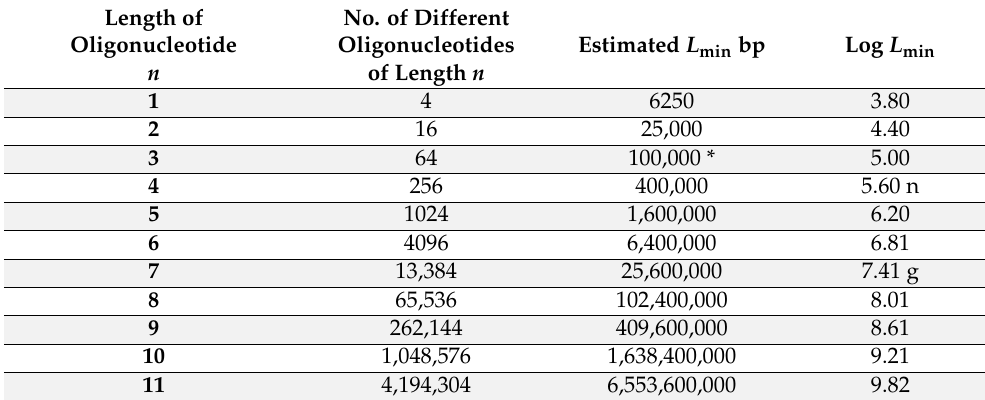
Table 2. Estimates of minimal length L min of a given DNA sequence, for which CSPR (strand symmetry) still approximately persists using an n -nucleotide oligonucleotide. As the reference value that we used for trinucleotides ( n = 3), we empirically estimated the minimal length of a genomic sequence (~100,000 bp). It follows that, for the estimate in this minimal sequence, each trinucleotide must be present ~1500 times. Using this estimate as a gauge, we determined estimates for minimal lengths of oligonucleotides of other